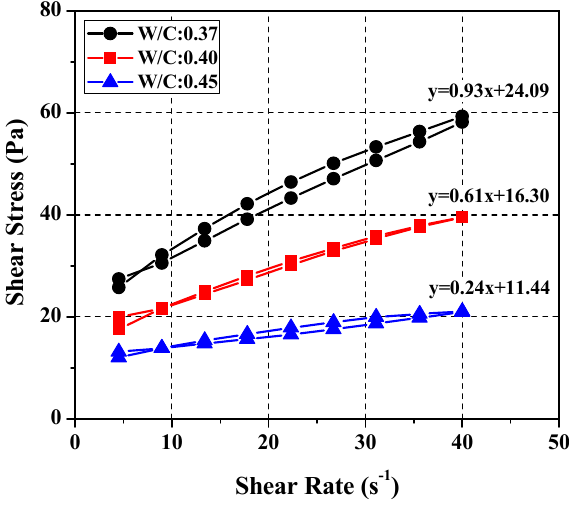
Figure 3. Test results of cement paste rheology.